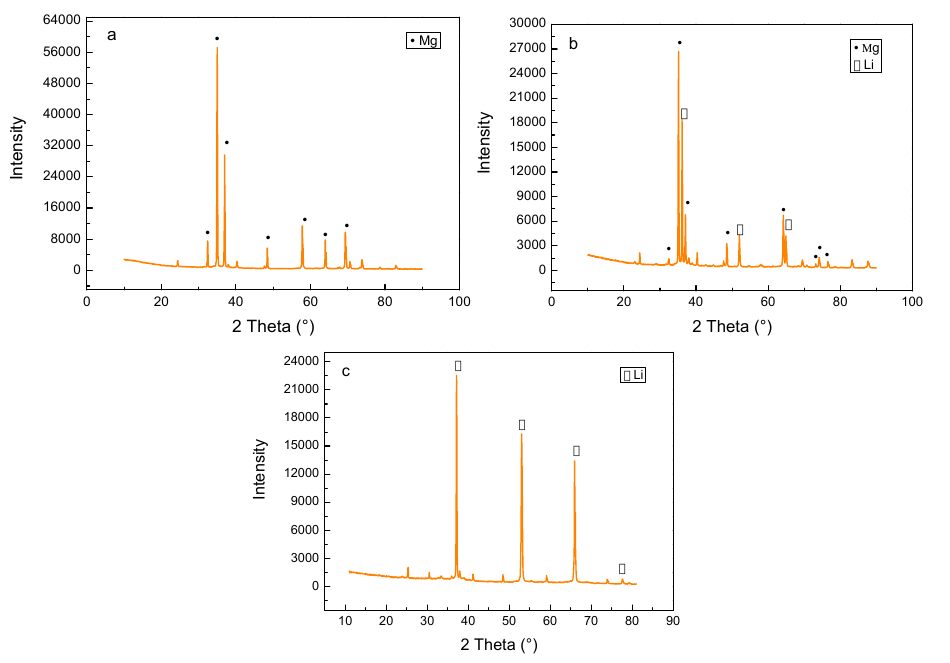
Figure 2. XRD patterns of as-cast alloys: ( a ) Mg-5Li-3Al-2Zn-0.2Y; ( b ) Mg-8Li-3Al-2Zn-0.2Y; ( c ) Mg-11Li-3Al-2Zn-0.2Y.